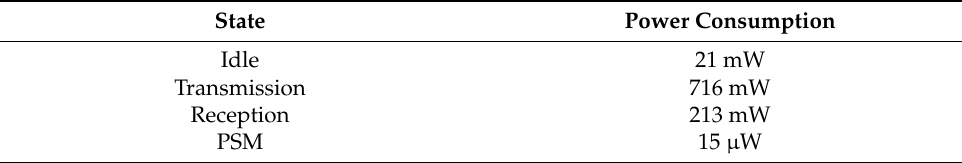
Table 8. Energy consumption on NB-IoT link.